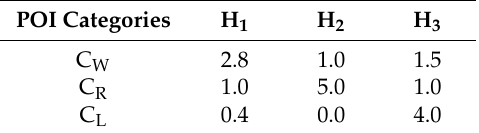
Table 1. POI point density for functional regions (points/km 2